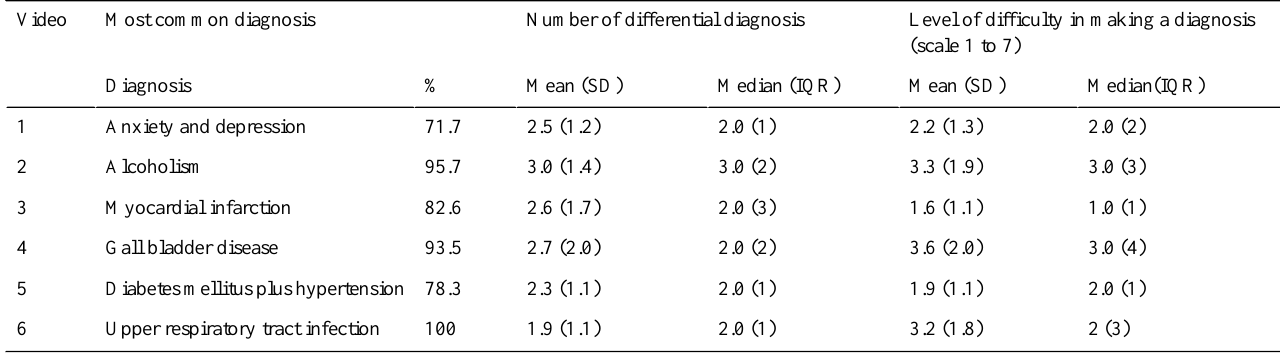
Table 4. Diagnosis and rating for each video (N=46).